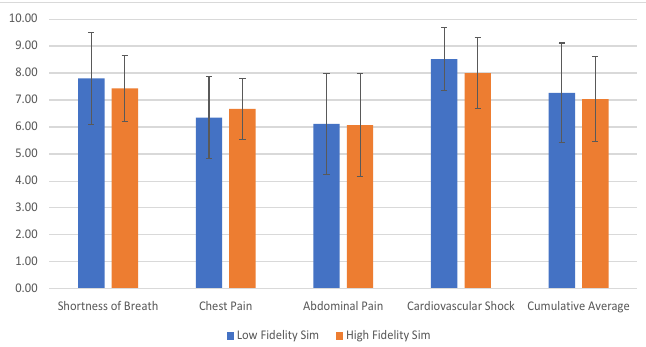
Figure 2. Post-test examination scores of high- versus low-fidelity simulation.